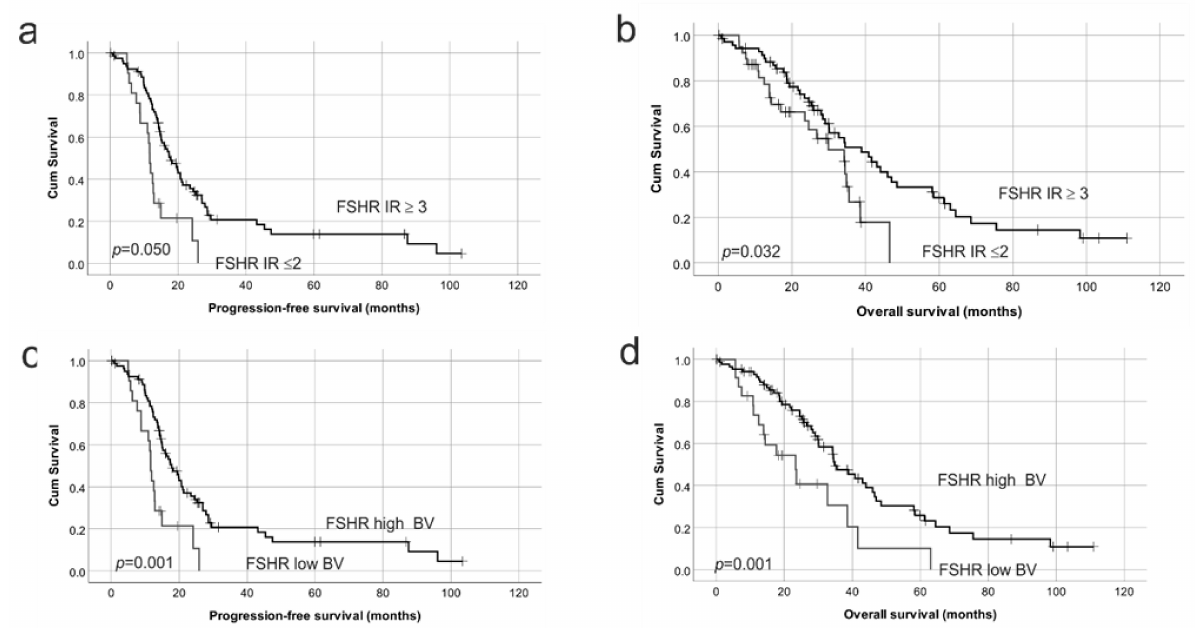
Figure 6. Kaplan–Meier survival analysis showing the relationship between FSHR protein expression with progression-free survival (PFS) and overall survival (OS) in HGSOC. ( a ) FSHR immunoreactive score (IR) in cancer cells with PFS; FSHR IR ≥ 3 (relapse; 52/69 patients), FSHR IR ≤ 2 (relapse; 27/33 patients) ( b ) FSHR IR score in cancer cells with OS, FSHR IR ≥ 3 (ovarian cancer death; 46/71 patients), FSHR IR ≤ 2 (ovarian cancer death; 22/39 patients). ( c ) FSHR IR score in blood vessels (BVs) with PFS, FSHR high BV (relapse; 61/81 patients), FSHR low BV (relapse; 18/21 patients). ( d ) FSHR IR score in BVs with OS, FSHR high BV (ovarian cancer death; 51/87 patients), FSHR low BV (ovarian cancer death; 17/23 patients). Log rank